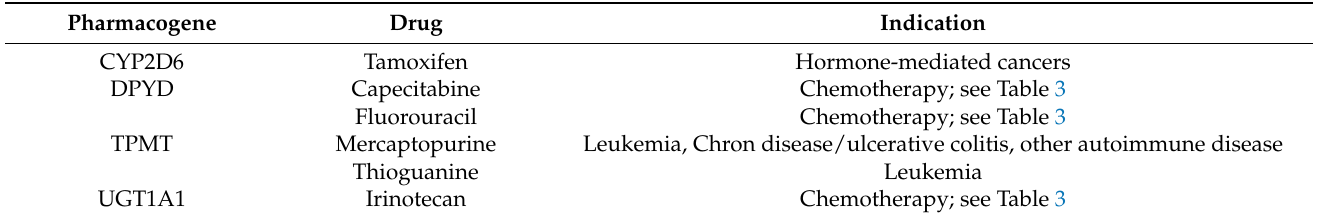
Table A4. List of CPIC level A pharmacogenes, associated anti-cancer drugs, and their